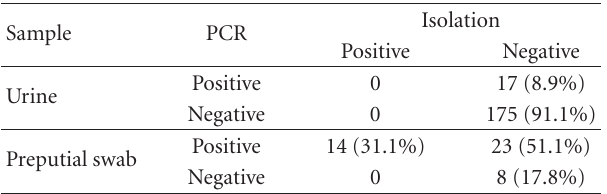
Table 3: Results of PCR and isolation of A. suis from urine and preputial